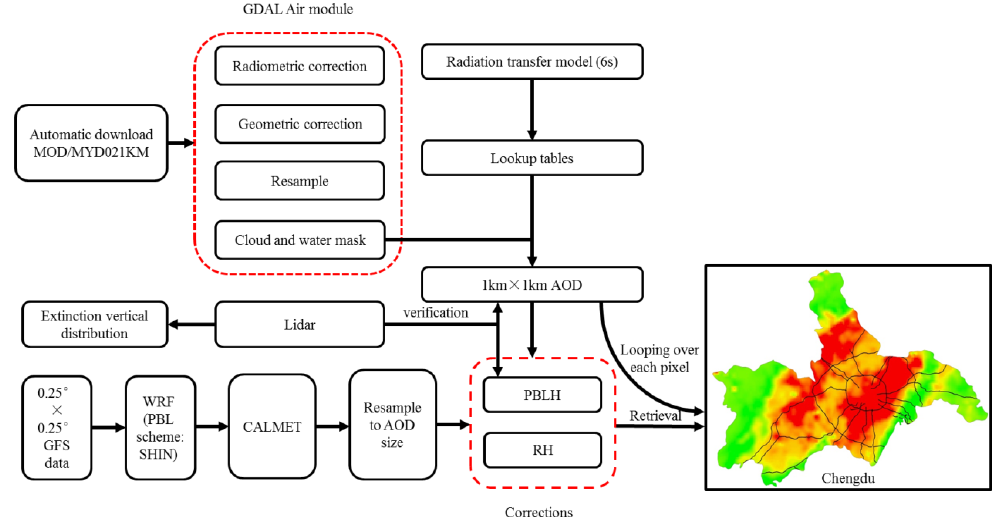
Figure 2. Flowchart of near real-time retrieval algorithm for PM 2.5 concentration over the Sichuan Basin.